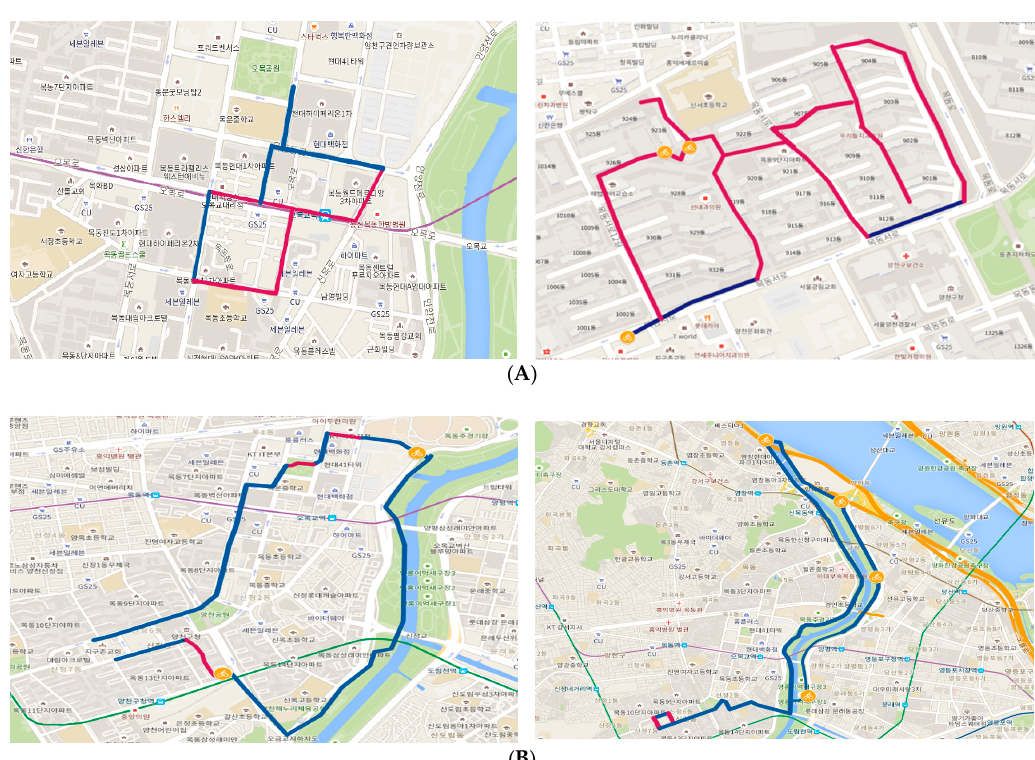
Figure 4. Examples of cycling behaviors by purpose of cycling. ( A ) Cycling for transport: (Female, 20s), Travel distance: 2.5 km, Average speed: 8.0 km/h, Cycling for commuting (working)—(left); (Male, 60s), Travel distance: 3.3 km, Average speed: 7.0 km/h, Cycling for running errands—(right). ( B ) Cycling for leisure: (Female, 20s), Travel distance: 6.7 km, Average speed: 9.7 km/h, Cycling for leisure around the park and neighborhood—(left); (Male, 40s), Travel distance: 14.7 km, Average speed: 12.7 km/h, Cycling for leisure to follow cycle tracks along the river—(right). Blue line: Bikeway, Red line: Not bikeway, Bicycle icon: Photo spot. The information in parentheses shows sex and age of participant.